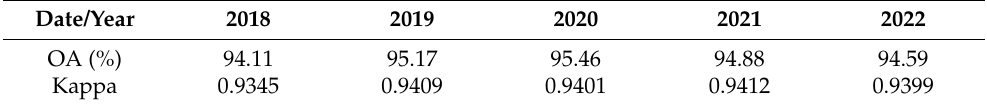
Table 6. Overall accuracy and kappa coefficient for time-series